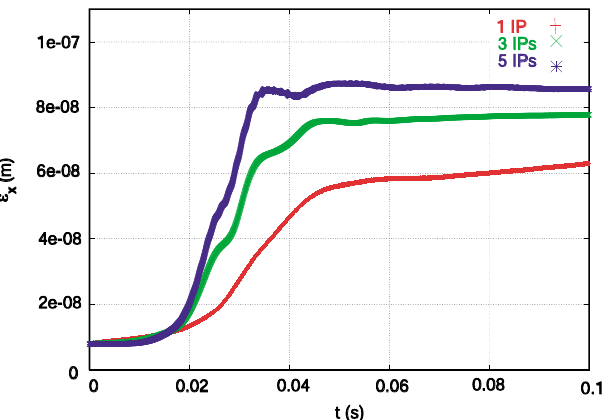
FIG. 80. (Color) Simulated evolution of LHC emittance versus (cid:3) 6 (cid:1) 10 11 m (cid:2) 3 when the bunch-slice time in seconds for (cid:31) e centroid motion is suppressed at each IP; the curves correspond to different numbers of electron-beam IPs [88].